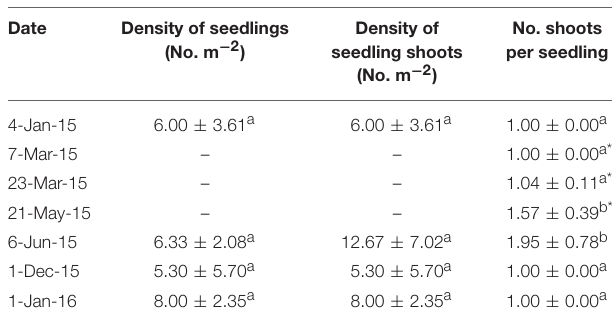
TABLE 4 | Densities of seedlings, seedling shoots and the number of shoots per seedling of Zostera marina in Huiquan Bay during